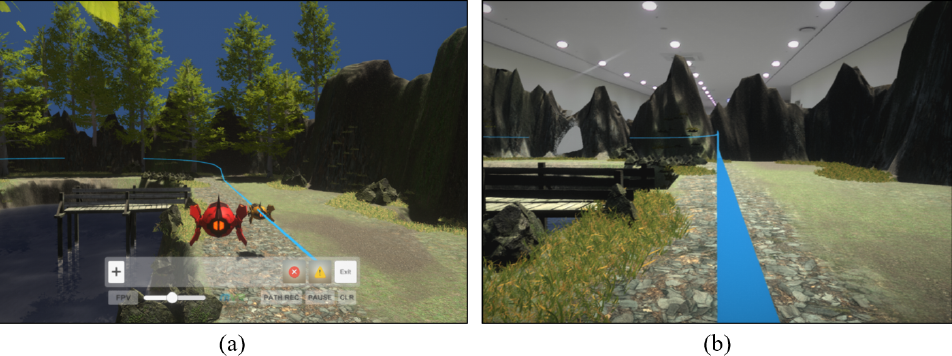
Figure 22. Flight path guidelines: ( a ) recorded in the space; ( b ) as seen by the drone